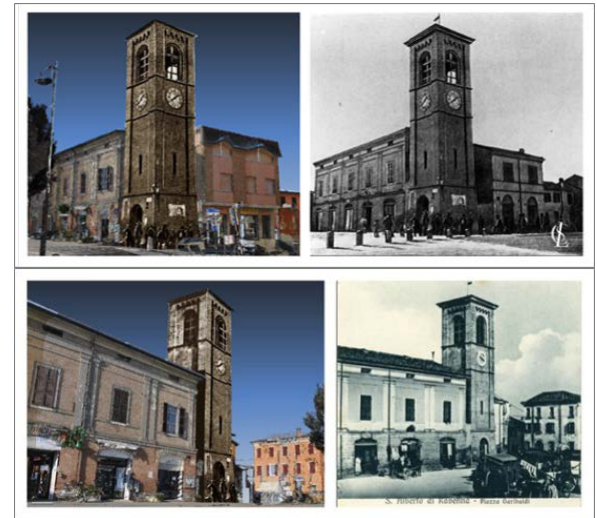
Figure 8. The 3D model of the tower inserted in the TLS cloud of the current context (on the left), from the same viewpoints and in comparison with some historical images (on the right).